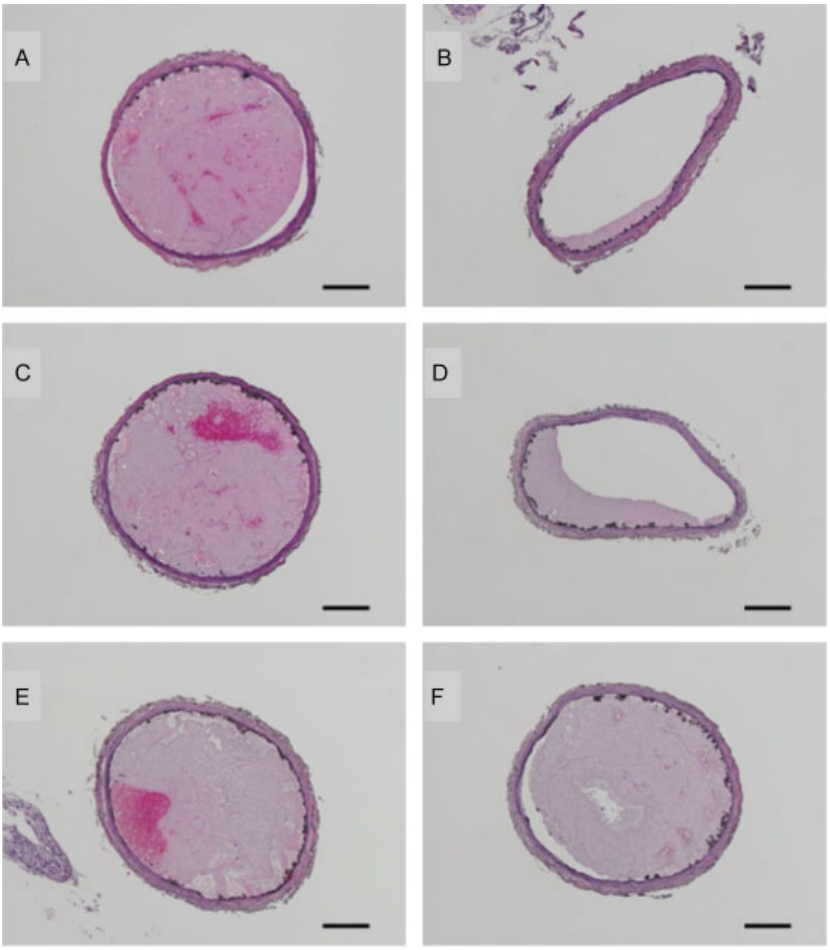
Fig. 3 Hematoxylin – eosin-stained cross-sections of injured carotid arteries. ( A ) Vehicle-treated wild-type (WT) (animal ID no. 105 in ► Fig. 1 ); ( B ) clopidogrel-treated WT (no. 202); ( C ) vehicle-treated apoE-de fi cient (no. 308); ( D ) clopidogrel-treated apoE-de fi cient (no. 406); ( E ) vehicle-treated diabetic apoE-de fi cient (no. 501); and ( F ) clopidogrel-treated diabetic apoE-de fi cient mice (no. 607). Scale bar ¼ 100 μ m. TH Open Vol. 1 No.